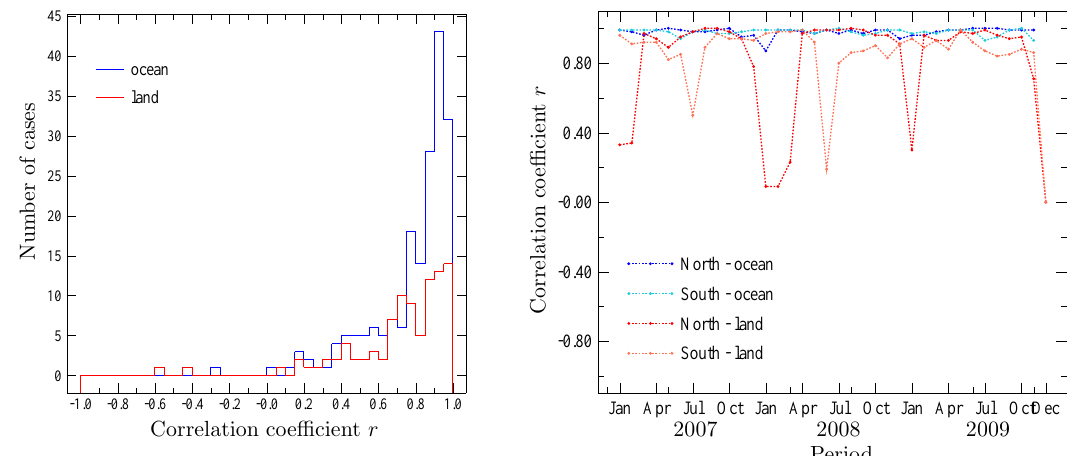
Fig. 10. Spatial variability (a) and temporal evolution (b) of the correlation coefficient r between σ P calculated at regional scale (bins of 10 ◦ of latitude and 20 ◦ of longitude), distinguishing areas above ocean from areas above land in 2008. In (b) , r is calculated at synoptic scale month by month from 2007 to 2009. Cases of monolayered liquid clouds with τ ≥ 5 and cc ≥ 0 . 95